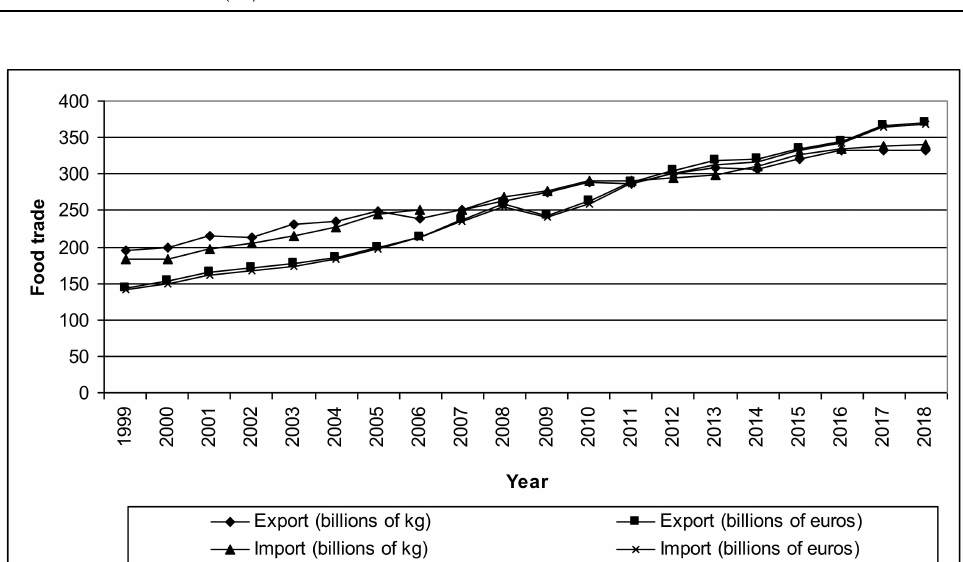
Figure 1. Intra-EU food trade in 1999–2018 according to the Eurostat